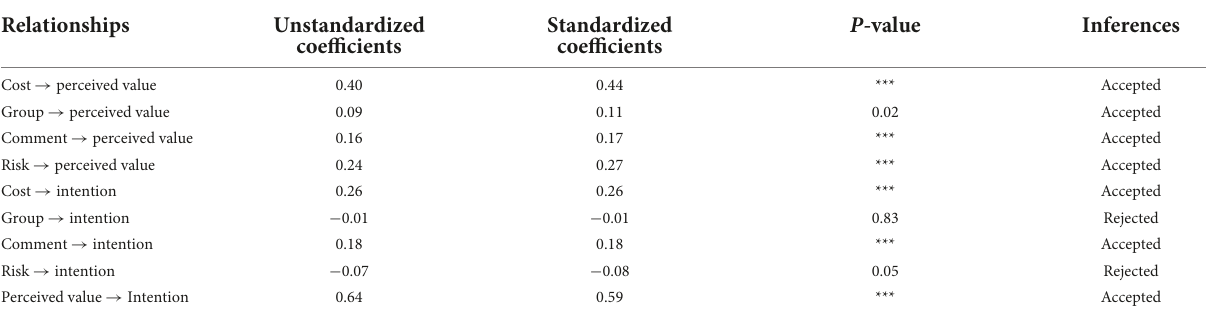
FIGURE1 Research framework and hypotheses.